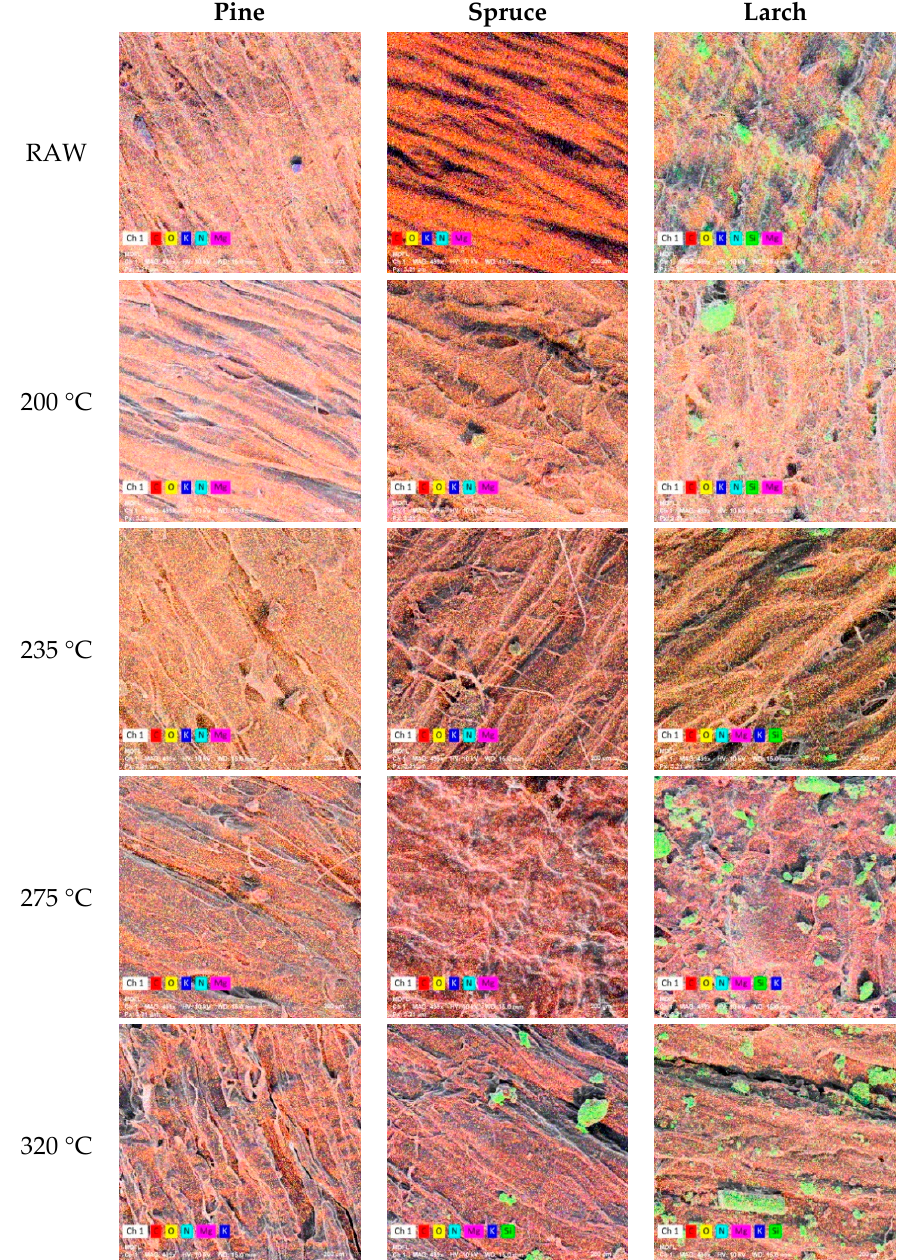
Figure 2. Examples of SEM images showing elemental composition of the surface of pine cone scales, spruce cone scales, and larch cone scales of reference and torrefied samples (magnification ×500). The color codes are as follows: C —red, O —yellow, K —dark blue, N —light blue, Mg —pink, Si —green. In the case of pine cone scales, the mean percentage share of carbon on the surface of reference samples was 60.2%. Torrefaction caused a decline in that element by approx. 11%, except for the ◦ samples exposed to 235 C, where carbon content decreased to 45.1%. A similar situation was observed (26.9% Mg and 16.7% K, respectively).